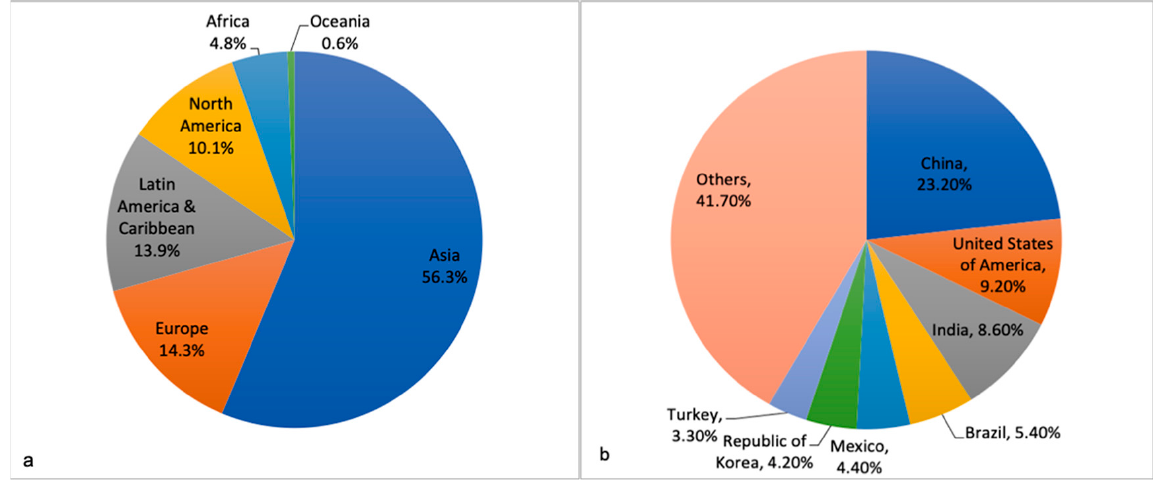
Figure 1. ( a ) Continent-wise and ( b ) Country-wise, percentage of new cases of thyroid cancer between 0–19 years; adapted from GLOBOCAN 2020 [20].